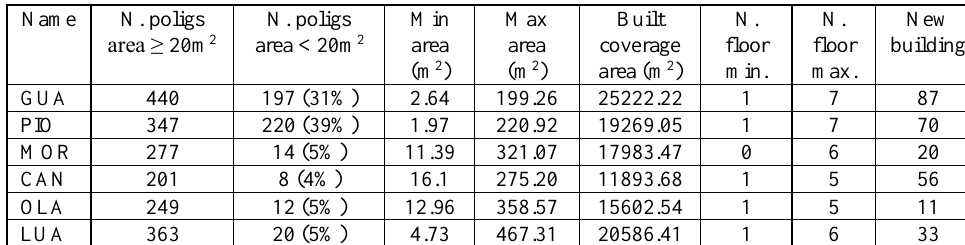
Table 5. 2017-year survey results